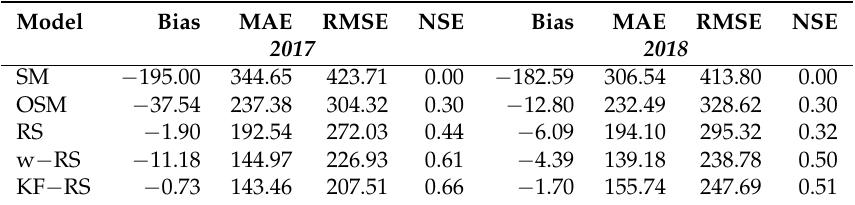
Table 4. Model diagnostic results for the predictions on the daily energy demand (summaries) for the years 2017 and